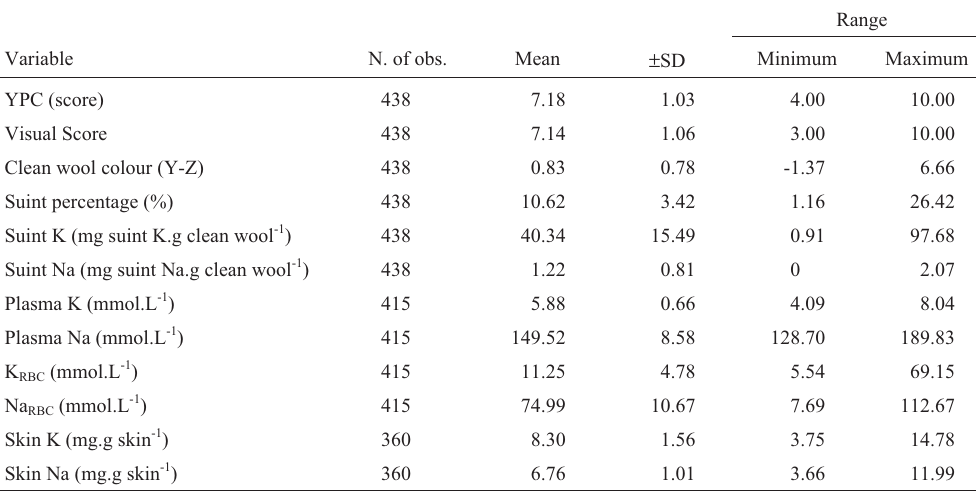
Table 1 - Overall means ( ± standard deviation) and range of the traits studied in Corriedale hogget fleece.